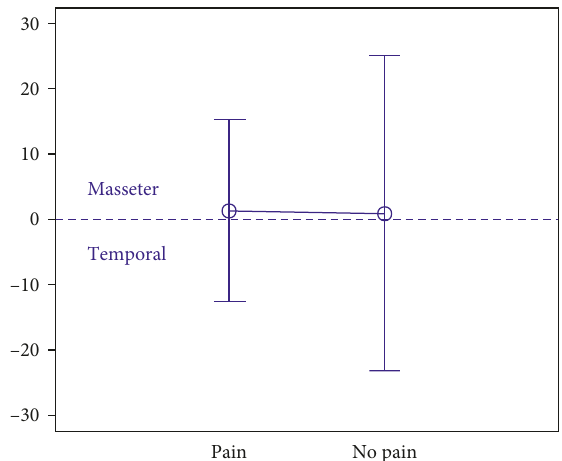
Figure 9: Activity index during swallowing in group of individuals with depression.